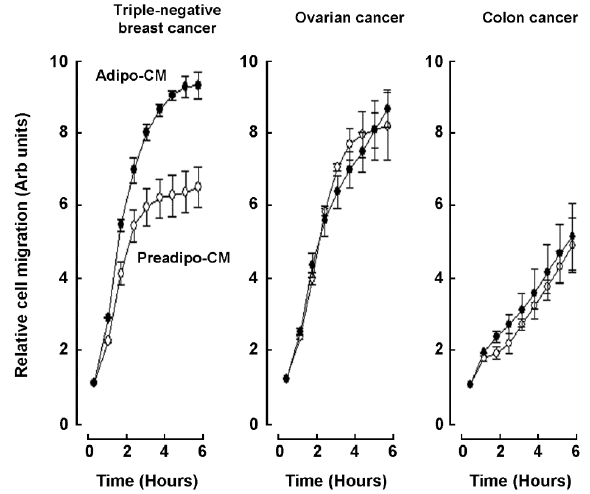
Figure 2. Adipocytes secretome, but not that of ADMSC, triggers increased TNBC-derived cell mi- gration. Real-time cell migration was performed using the xCELLigence System-RTCA as described in the Methods section in response to ADMSC conditioned media (Preadipo-CM, open circles) or adipocytes conditioned media (Adipo-CM, closed circles). Cells assessed were human TNBC-derived MDA-MB-231, ES-2 ovarian carcinoma, and HT-29 colorectal adenocarcinoma.